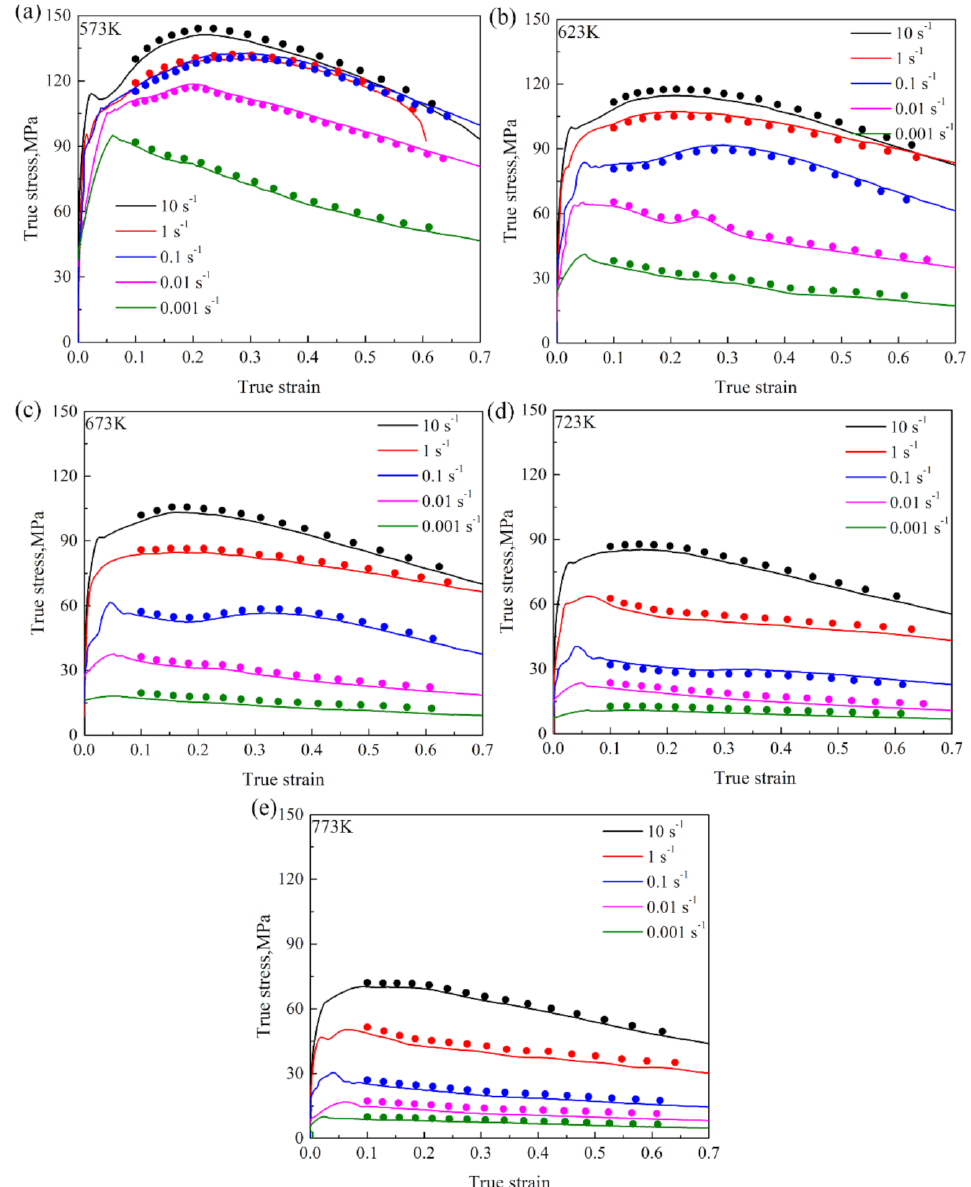
Figure 7. Experimental (solid lines) and predicted (scatter plot) flow stress of the alloy at ( a ) 573 K, ( b ) 623 K, ( c ) 673 K, ( d ) 723 K and ( e ) 773